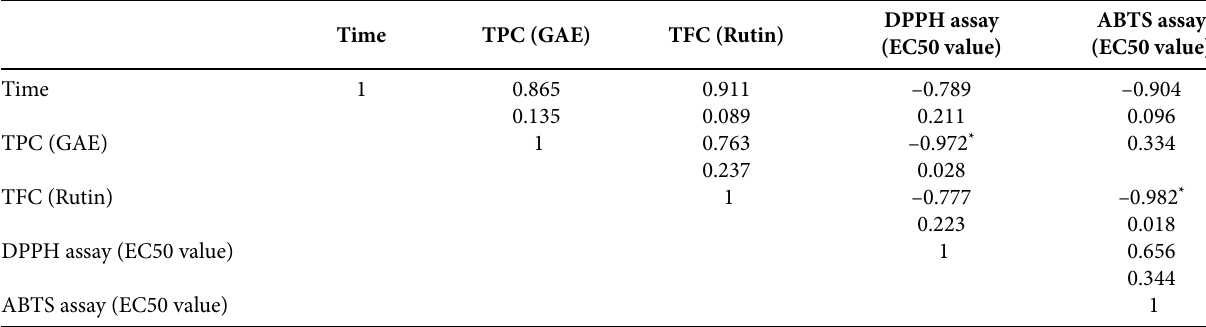
Table 4. Linear correlations between the analyzed parameters